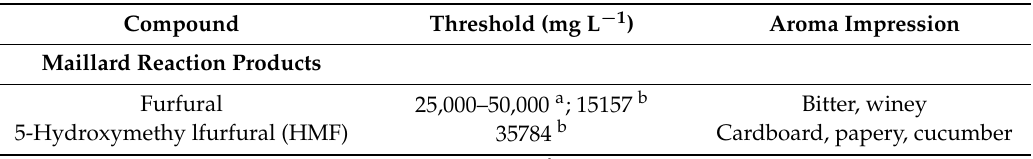
Table 2. Threshold values and aroma impressions of most important Maillard Reaction products present in